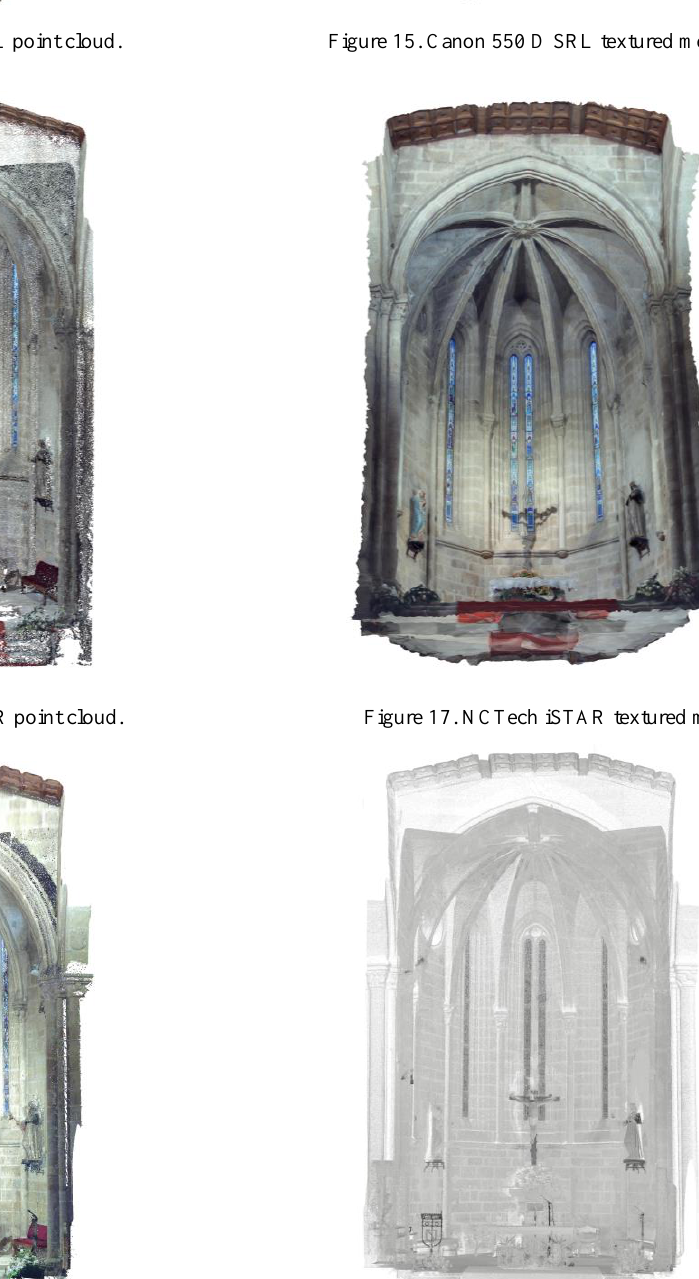
Figure 18. FARO Focus 3D X130 coloured point cloud. Figure 19. FARO Focus 3D X130 grey point